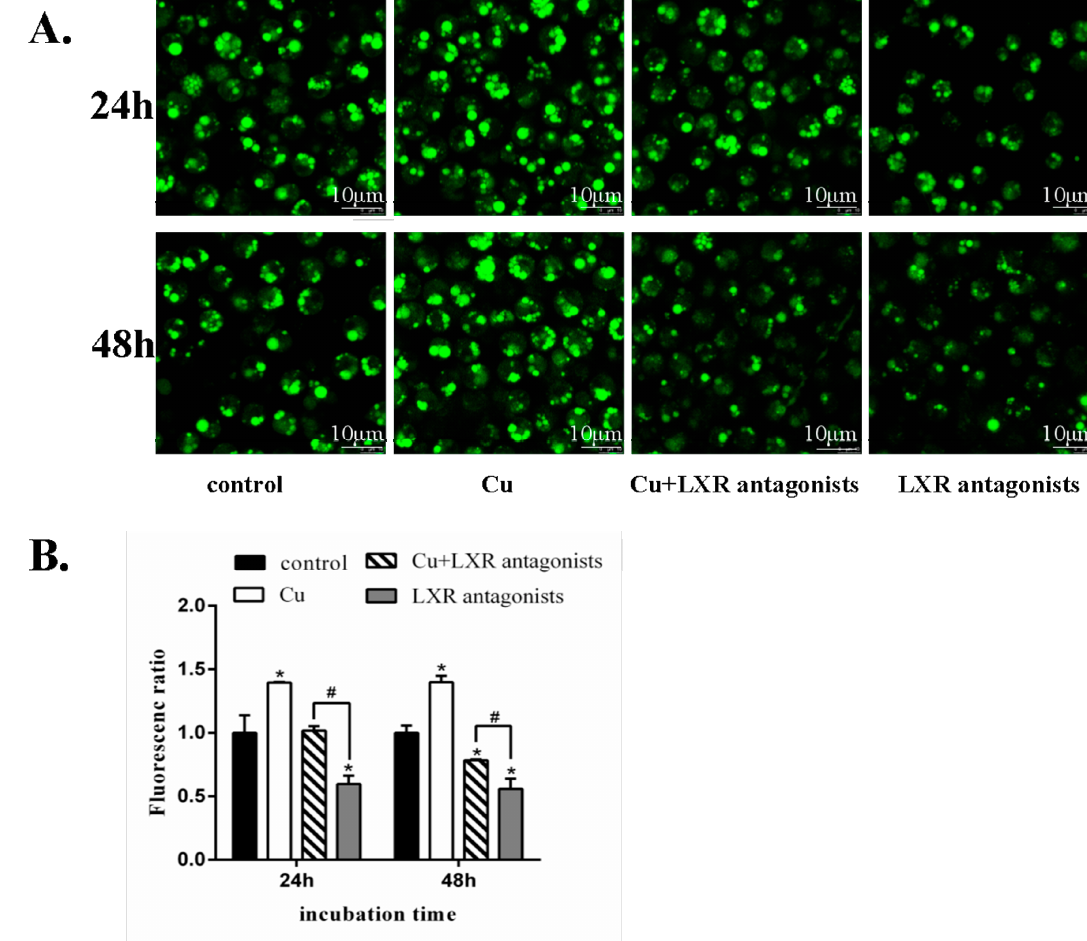
Figure 7. Cu-induced changes in hepatic lipid droplets of yellow catfish. ( A ) Images of hepatocytes stained by BODIPY output by fluorescence scanning confocal microscopy. ( B ) Quantitative analysis of the ratio of fluorescence intensity over area by Image J. Mean of the results from the control was set as 1. The data are mean and standard deviation (SD) of separate transfections ( n = 3). * p < 0.05, compared with control. # p < 0.05, compared with single LXR antagonists incubation (independent-samples T -test).